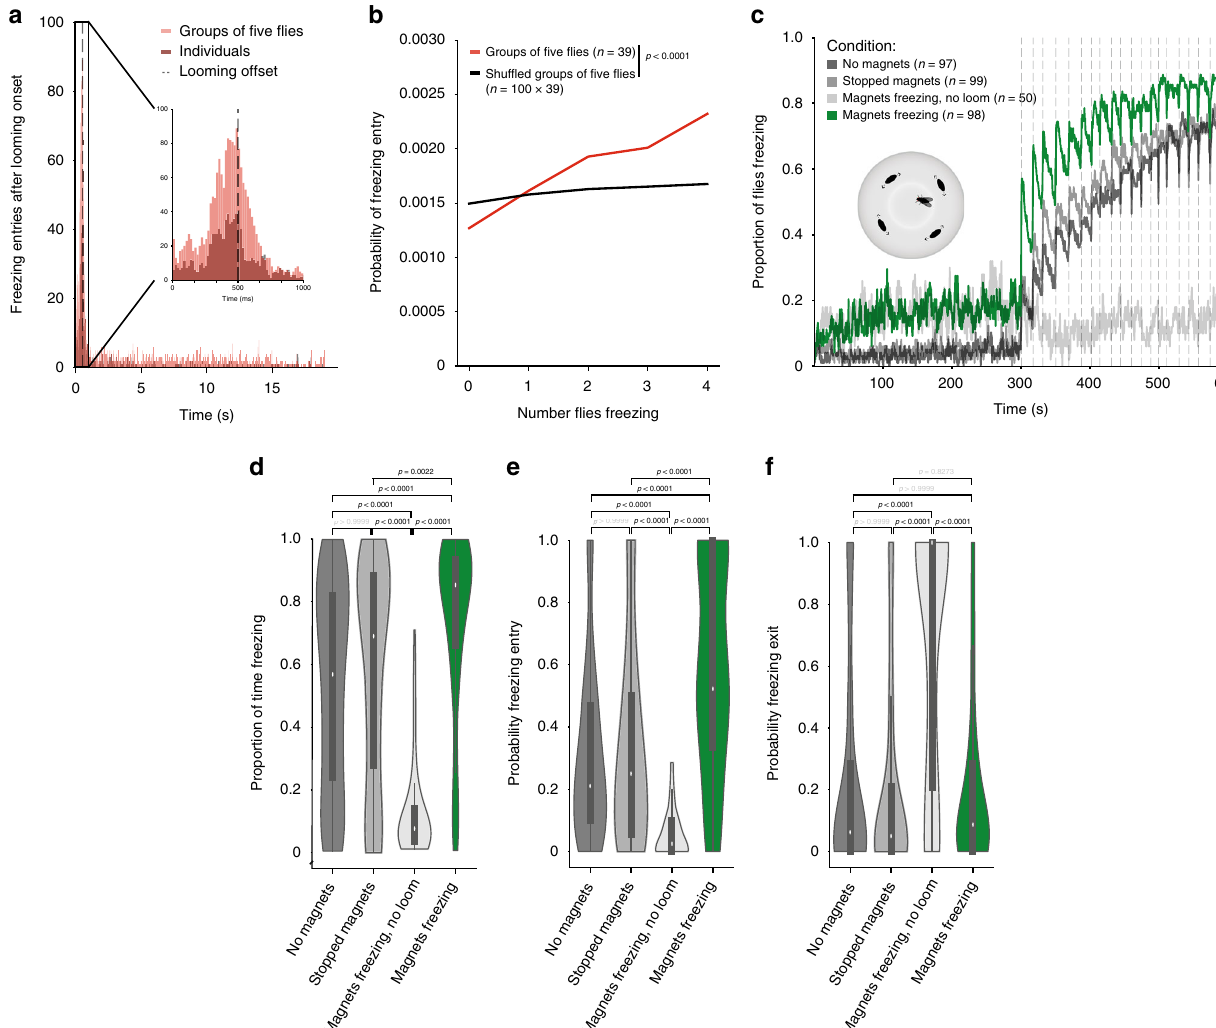
Fig. 2 The group effect on individual freezing entry. a Distribution of freezing entries after looming onset for fl ies tested individually and in groups of fi ve. b Probability of freezing entry at time t as a function of the number of other fl ies freezing at t − 1 (see methods). P -value results from χ 2 contingency test (G- test). c – f Simulating groups of fi ve using movable magnets (stopped magnets – immobile magnets throughout the experiment; magnets freezing – magnets move during baseline becoming immobile magnets from the onset of the stimulation period). c Proportion of fl ies freezing throughout the experiment. d – f Violin plots representing the probability density of individual fl y data bound to the range of possible values, with boxplots (elements: center line, median; box limits, upper (75) and lower (25) quartiles; whiskers, 1.5× interquartile range). d Proportion of time spent freezing throughout the experiment. e Probability of freezing entry after looming presentation. f Probability of freezing exit before the following looming stimulus. P -values result from Kruskal – Wallis statistical analysis followed by Dunn ’ s multiple comparisons